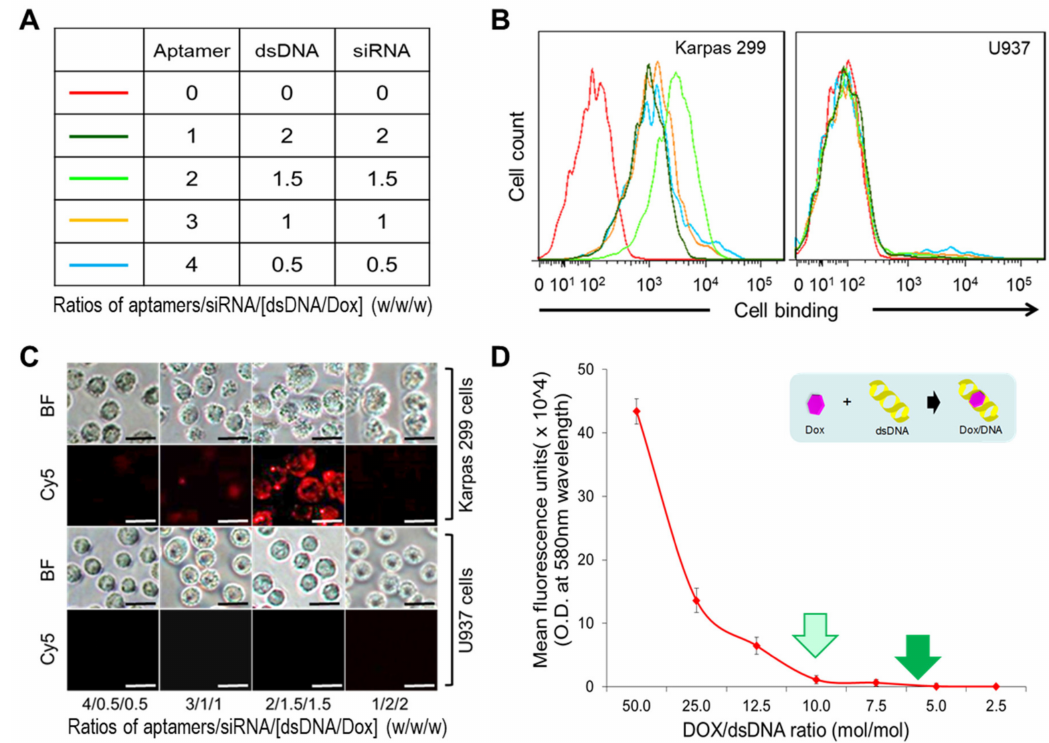
Figure 4. Optimizing protamine nanoparticle products. ( A ) To optimize cell-targeting capacity, testing nanoparticles were fabricated with a 1.5:1.0 ratio of protamine to total nucleotide components, but di ff erent ratios of aptamers, dsDNA, and siRNA ( w / w / w ), as listed. ( B ) Cell binding of the